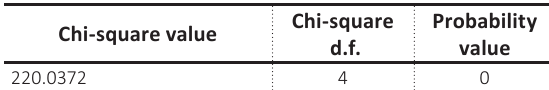
Table 5. Hausman’s test